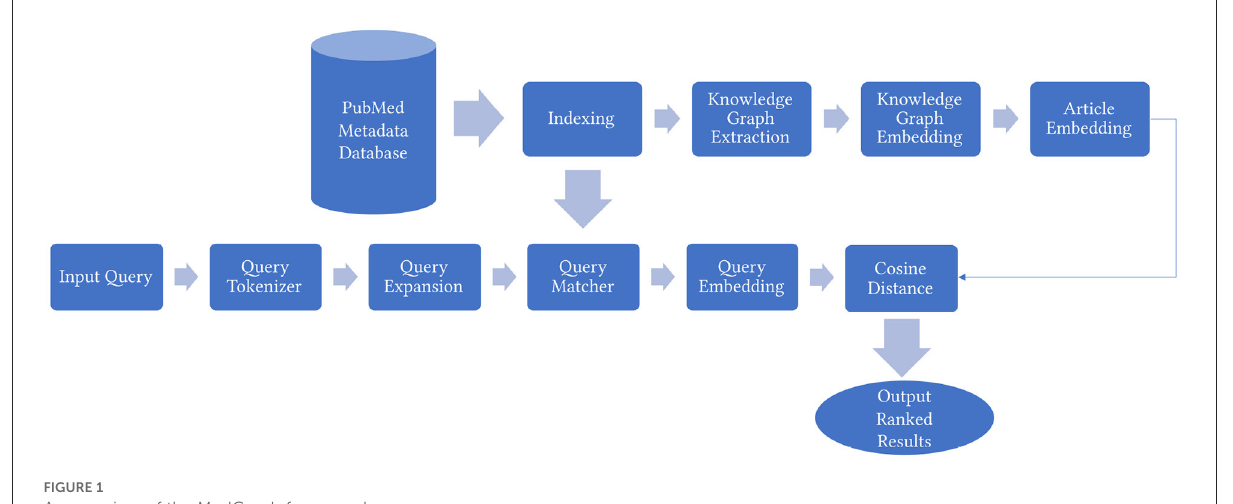
FIGURE1 An overview of the MedGraph framework.